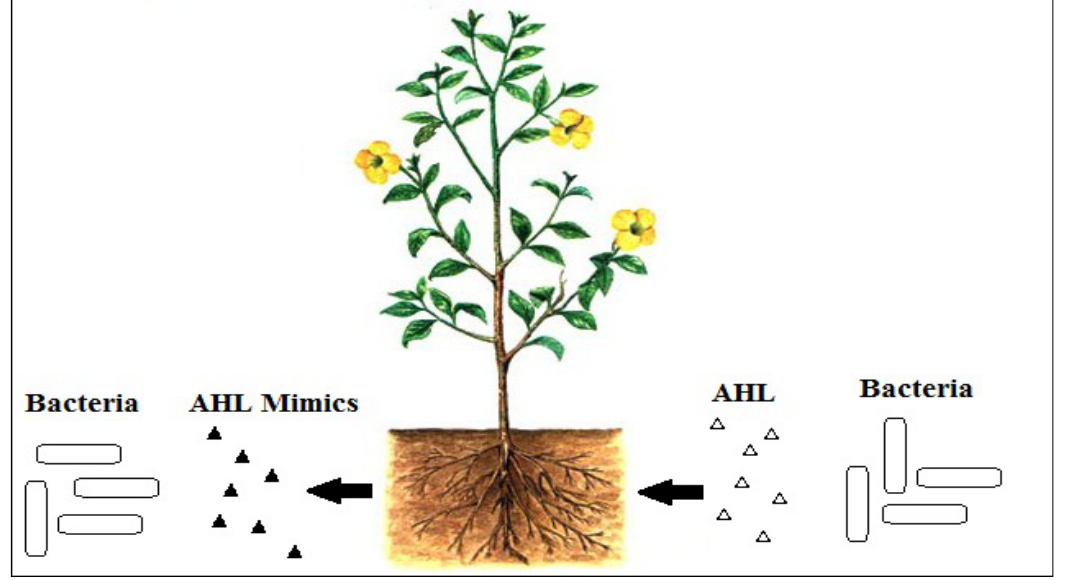
Figure 2. A schematic figure which shows the QS interactions between the plants and the bacteria. Bacteria release AHL molecules [  ] which can cause virulence such as biofilms and crown gall formation. The plants, on the other hand, will response to the bacteria signaling molecules by releasing AHL mimic compounds [  ] for defense purposes and this will then affect the bacterial QS